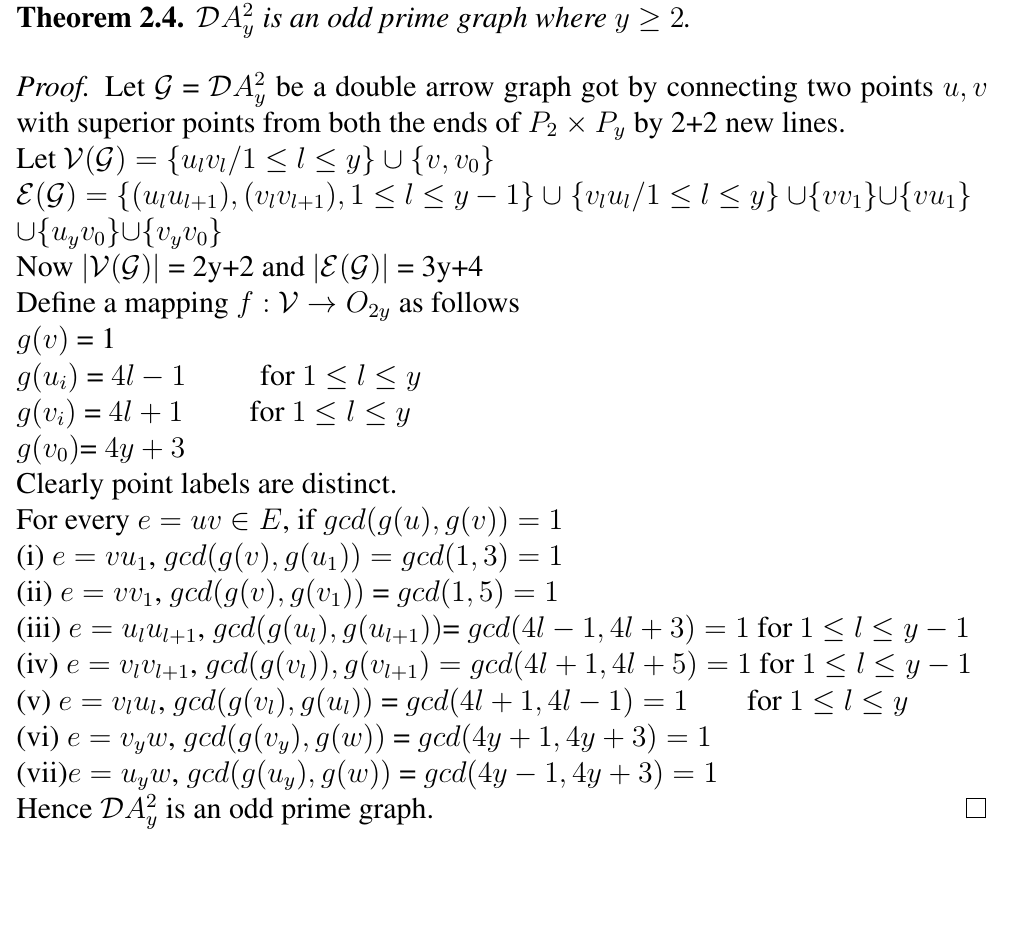
and its odd prime y